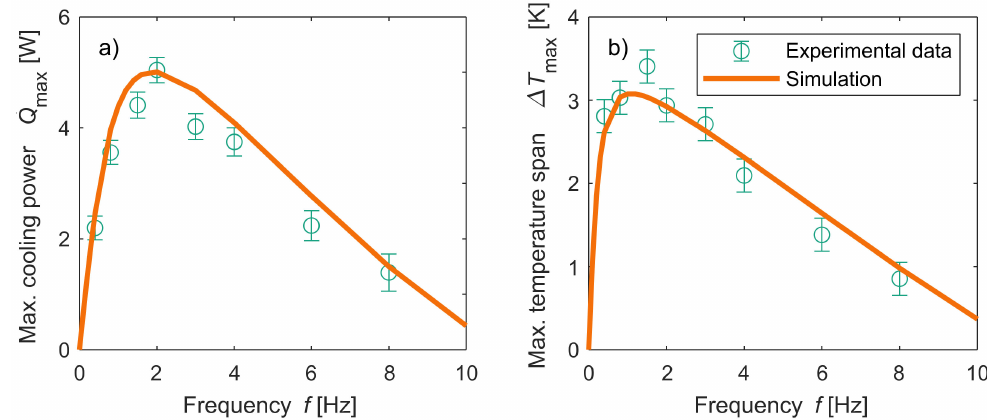
Figure 9. The results of the simulation compared with the measurement data pertaining to the maximum cooling power ( a ) and the maximum temperature span ( b